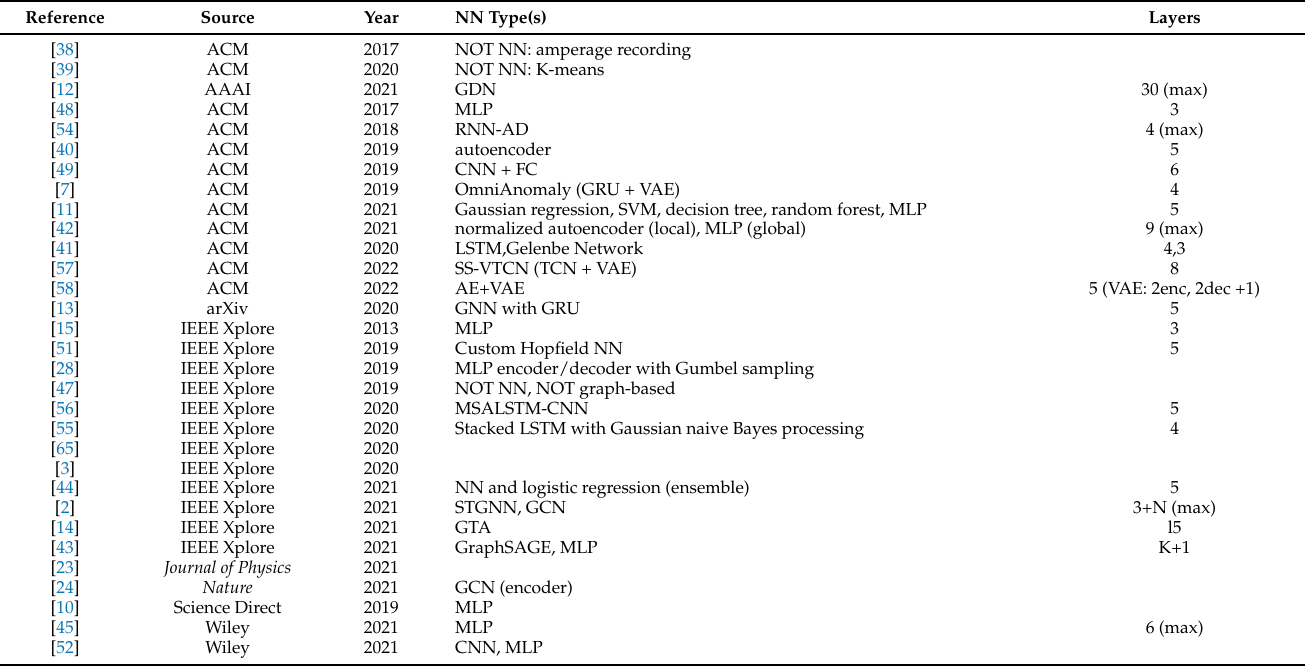
Table A1. Breakdown of ML types